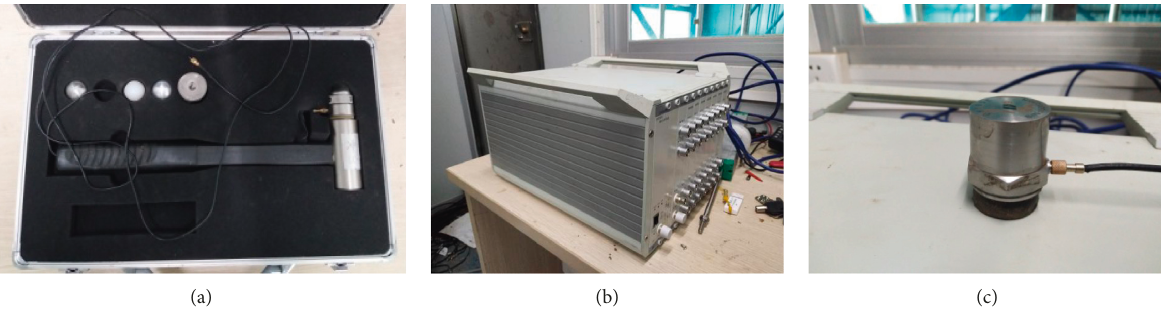
Figure 2: (a) Cohesive hammer; (b) DHDAS dynamic signal acquisition and analysis system; (c) acceleration